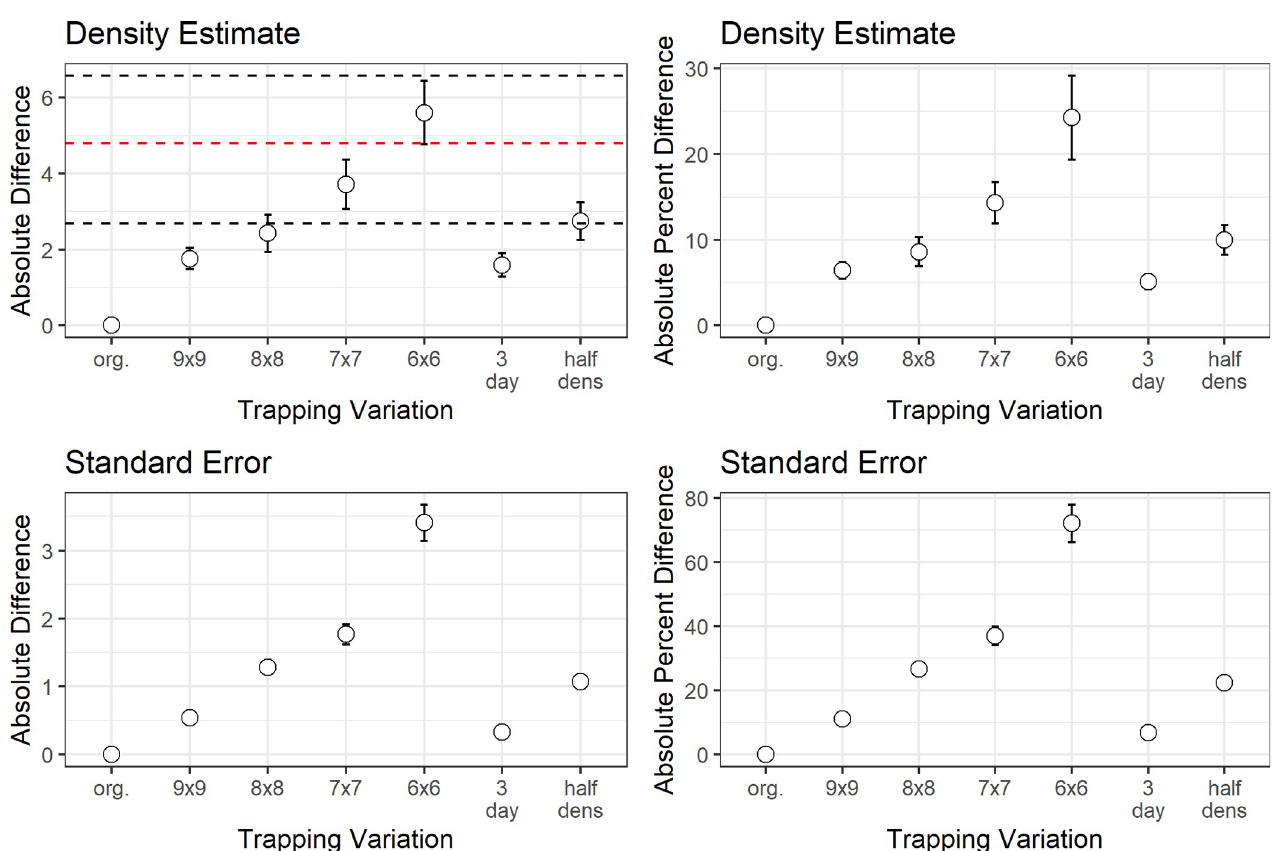
Fig 4. Absolute difference and absolute percent difference for both density estimates and standard error (SE) across years for the full dataset compared to the subsampled datasets. (lower black line indicates the minimum SE observed [2017], red line indicates the mean SE, and upper black line indicates the maximum SE observed